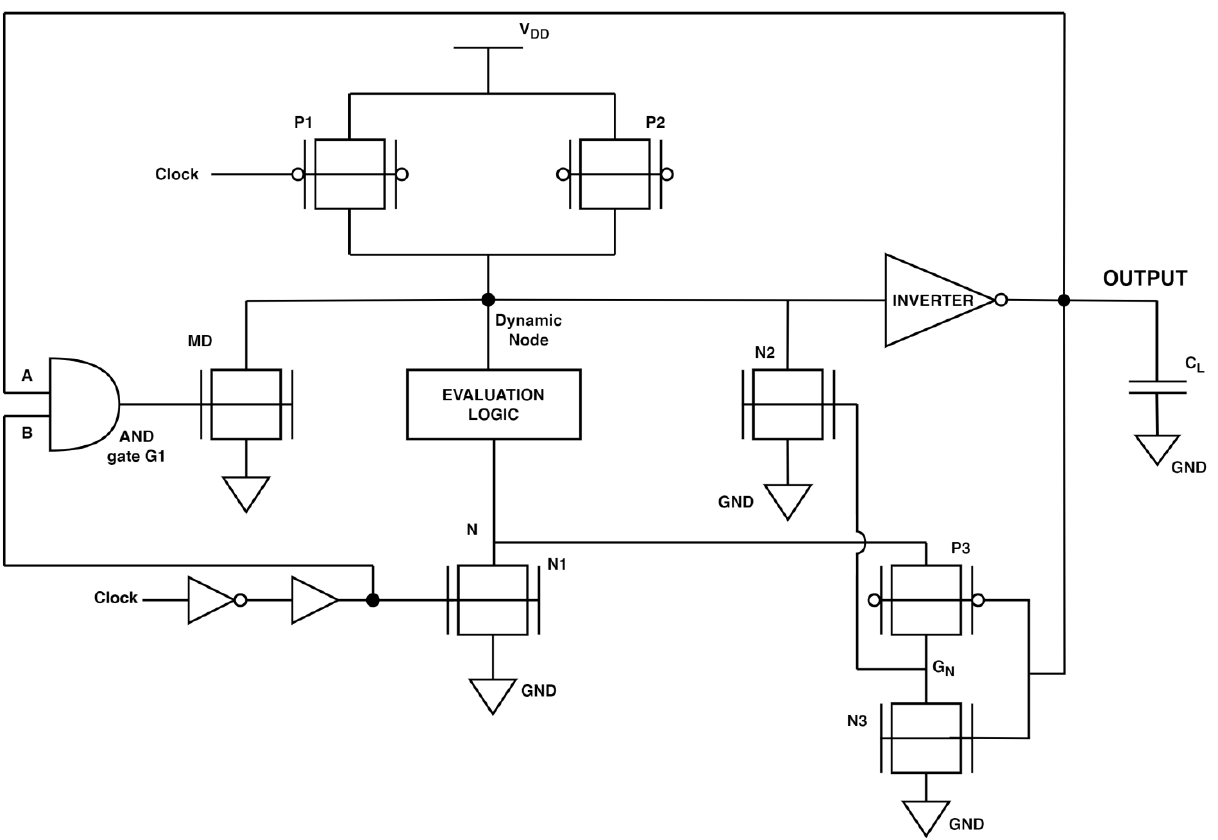
Figure 9. Modified high-speed clocked delay (MHSCD) [26].